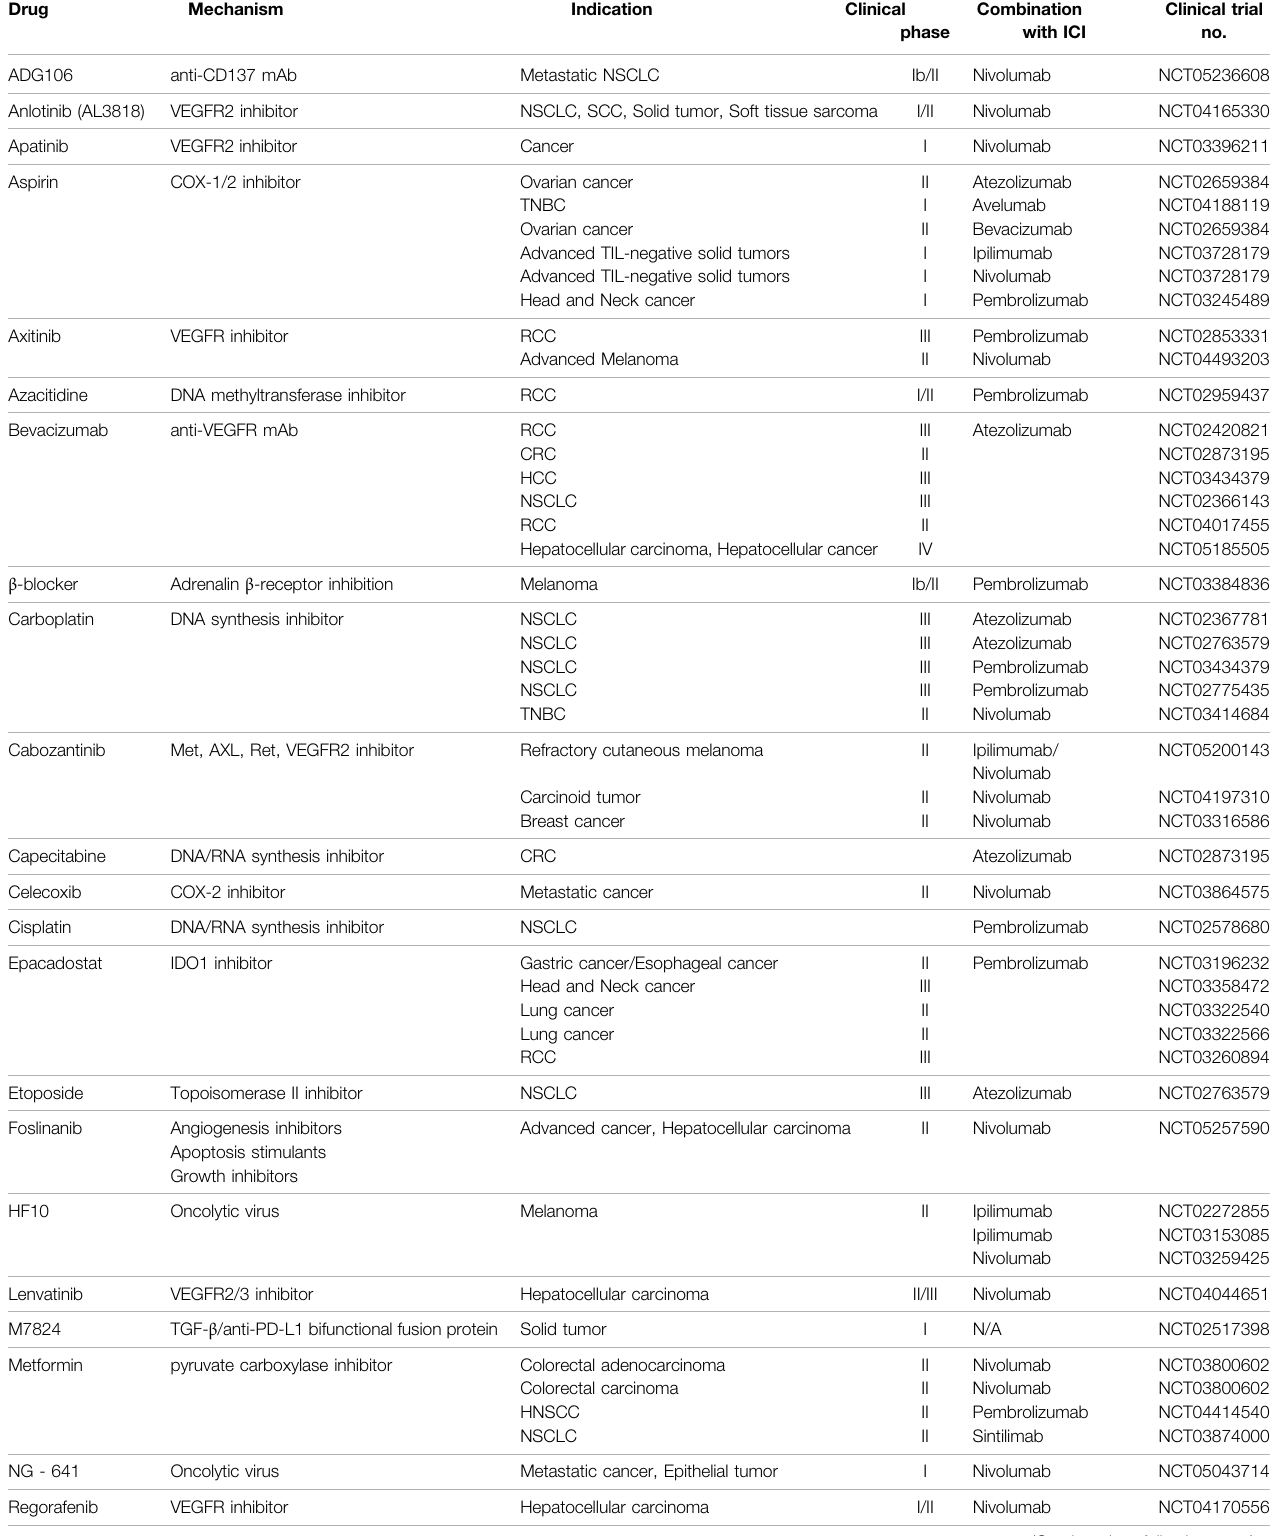
TABLE 1 | Combination TME-targeted therapy and